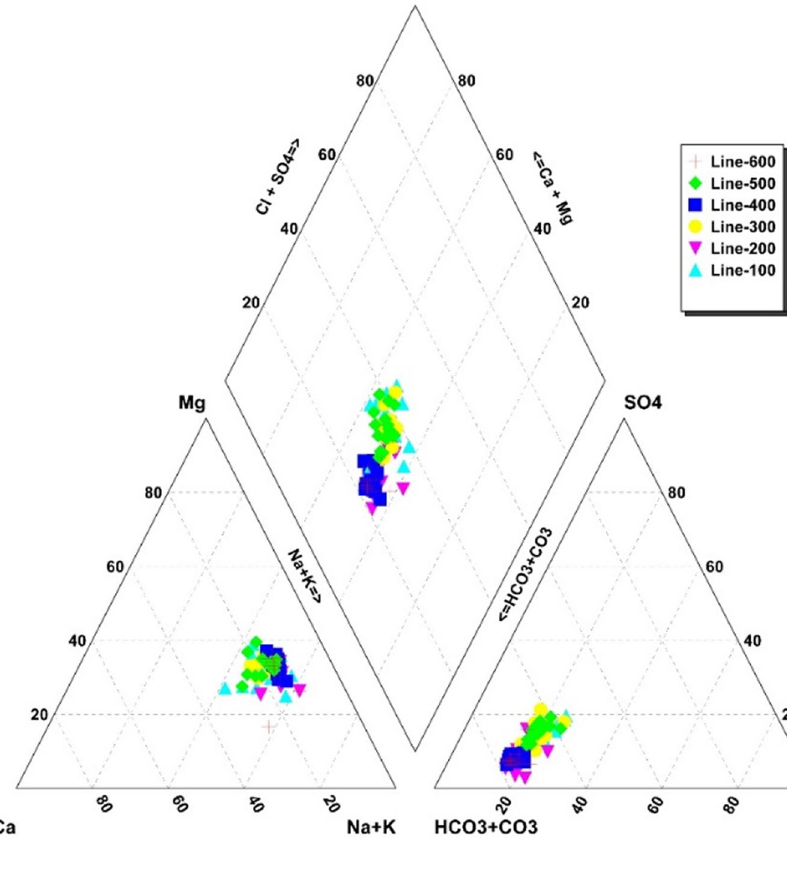
Fig.11 TDS Map of Tazerbo